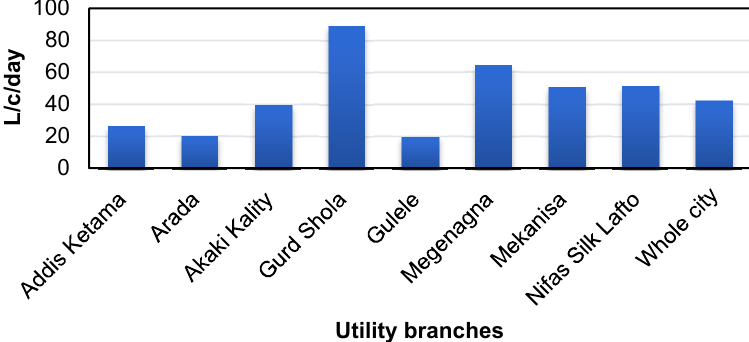
Figure 5. Per capita water consumption (L cap − 1 day − 1 ) of each utility branch based on bill data in 2017.